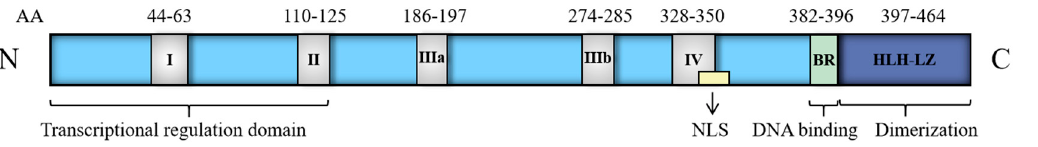
Figure 1. Structure of N-Myc. Silver boxes represent Myc homology Box (MB) I–IV. Green Box represents Basic Region (BR), which is DNA-binding domain. Dark blue Box represents Helix-Loop- Helix-Leucine Zipper (HLH-LZ), associated with MYC dimerization. Yellow box represents nuclear localization signal (NLS). Blue bottom frame is region of N-Myc with relatively low disorder score.